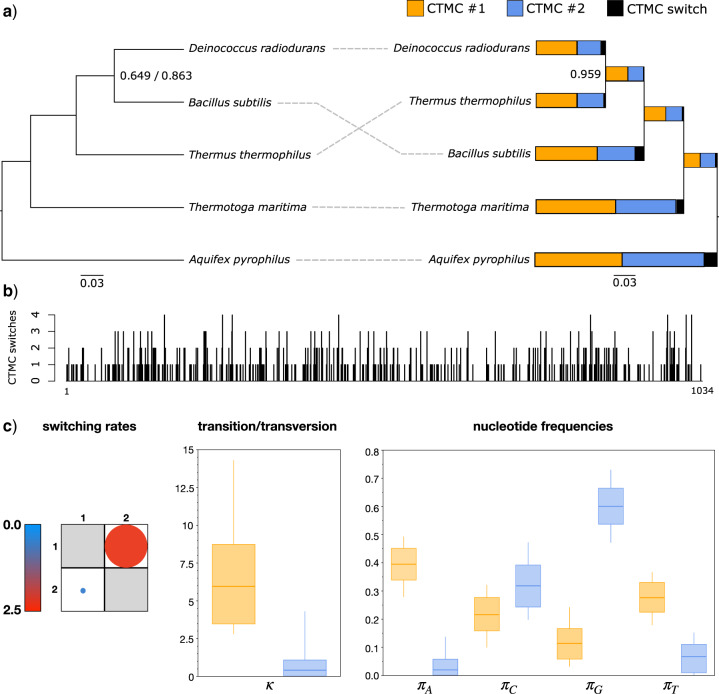
a) Maximum clade credibility (MCC) phylogeny relating five bacterial 16S sequences; unlabeled nodes have \documentclass[12pt]{minimal}
\usepackage{amsmath}
\usepackage{wasysym} 
\usepackage{amsfonts} 
\usepackage{amssymb} 
\usepackage{amsbsy}
\usepackage{upgreek}
\usepackage{mathrsfs}
\setlength{\oddsidemargin}{-69pt}
\begin{document}
}{}$>$\end{document}0.9999 posterior probability. Standard nucleotide substitution models that assume among-site rate variation (ASRV) erroneously cluster the two mesophiles together with high posterior probability (0.649 for HKY and 0.863 for GTR in the topology on the left). However, an MMM(HKY)\documentclass[12pt]{minimal}
\usepackage{amsmath}
\usepackage{wasysym} 
\usepackage{amsfonts} 
\usepackage{amssymb} 
\usepackage{amsbsy}
\usepackage{upgreek}
\usepackage{mathrsfs}
\setlength{\oddsidemargin}{-69pt}
\begin{document}
}{}$_{22A}$\end{document} yields the correct clustering of the Deinococcus radiodurans and the Thermus thermophilus sequences with high posterior probability (topology on the right); each branch is annotated with the proportion of sites in each of the continuous-time Markov chain (CTMC) models, based on the maximum a posteriori (MAP) phylogeny. b) Number of CTMC model switches per alignment site based on the most probable hidden state realizations of the MMM on the MAP phylogeny; of the full alignment of 1304 sites, 761 sites are estimated not to switch between CTMC models. c) Mean posterior parameter estimates of the MMM show asymmetric switching between models (with circle sizes proportional to rate switching intensity) with pronounced differences in transition/transversion ratios and base frequencies.